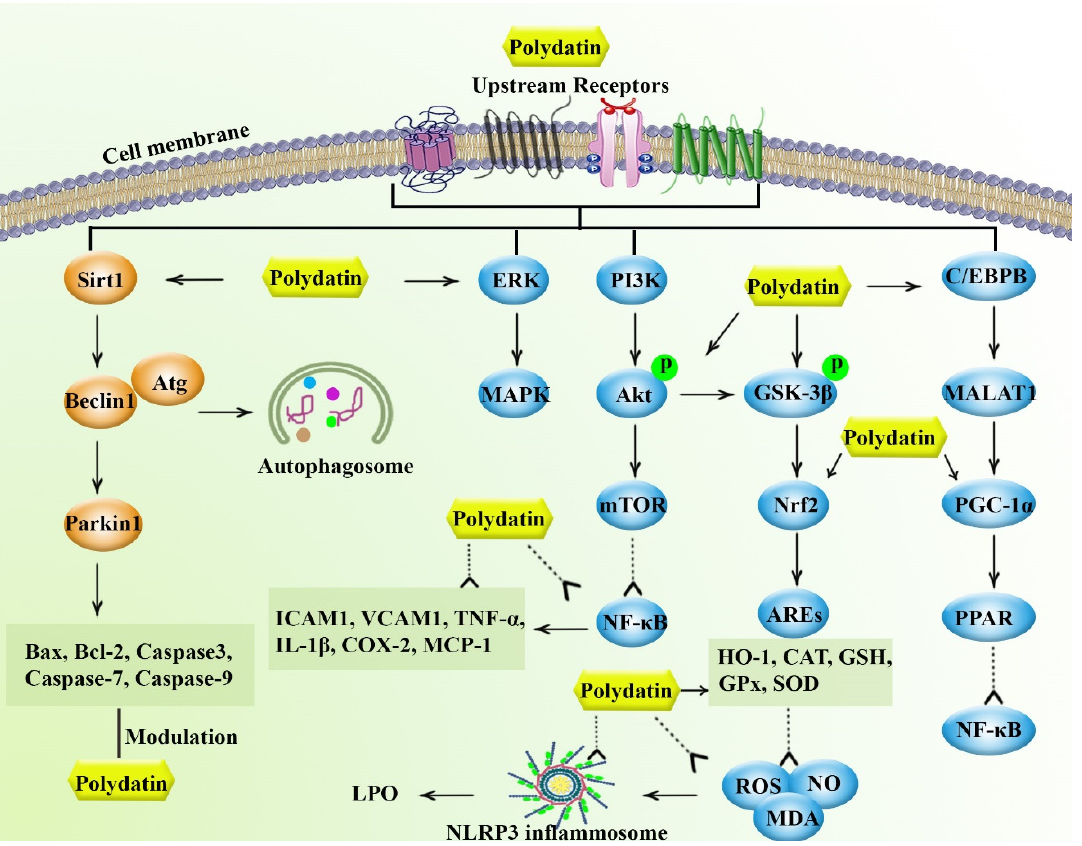
Figure 4. Major pharmacological mechanisms and therapeutic targets of polydatin towards biolog-